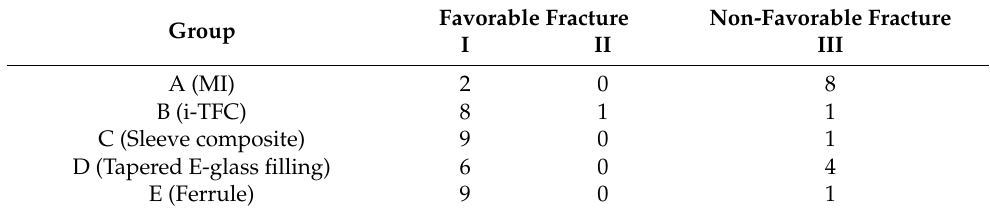
Table 3. Distribution of fracture modes per group ( n = 10). Favorable Group